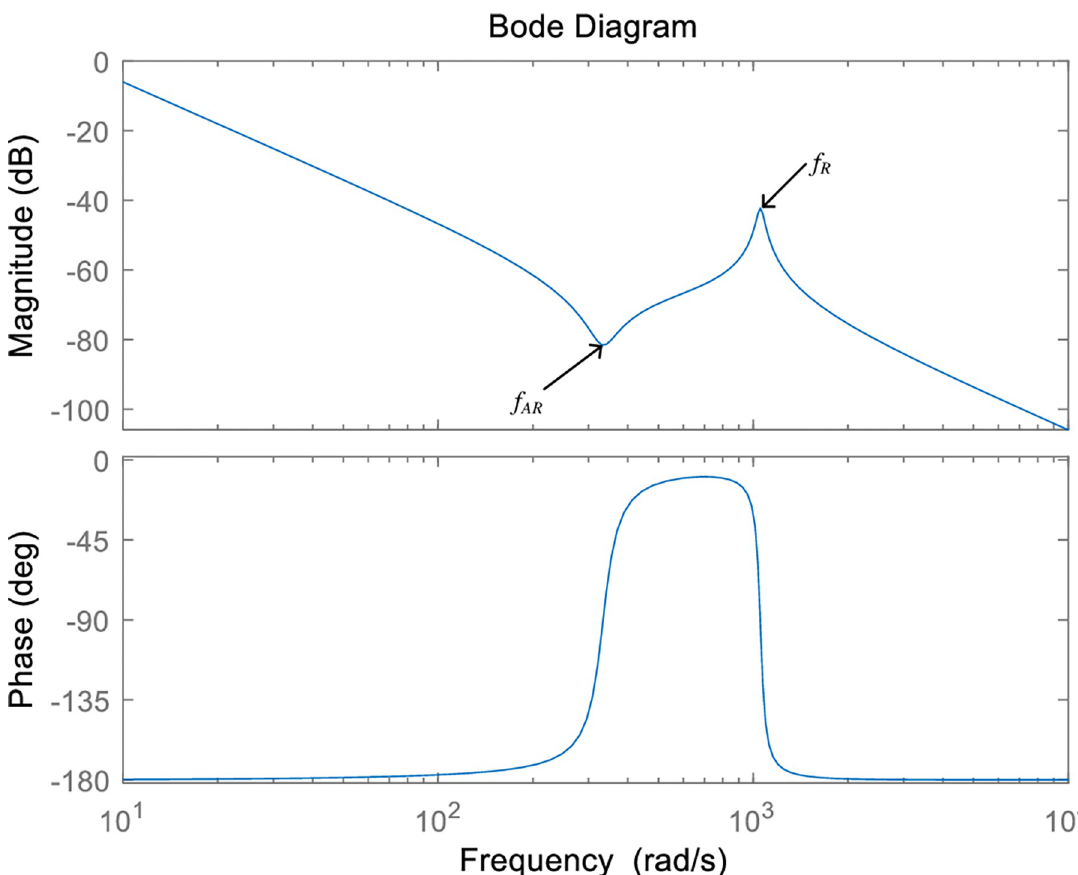
Fig 4. Frequency characteristic curve including the mechanical resonance